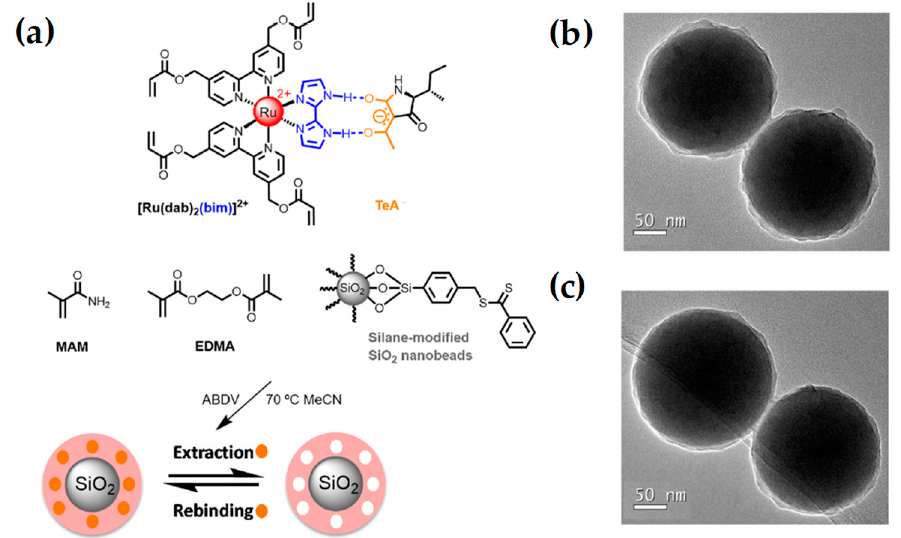
Figure 7. ( a ) Scheme of the preparation of the luminescent SiO 2 @Ru-MIP core–shell nanoparticles for TeA-recognition. The RAFT polymerization was initiated with ABDV (2,2 ′ -azobis(2,4-dimethyl)valeronitrile) and heat. ( b , c ) TEM images of the obtained MIP and NIP core–shell nanoparticles, respectively. The orange circles represent tenuazonic acid (TeA) molecules. Reprinted from [40], with permission from Elsevier, 2021.